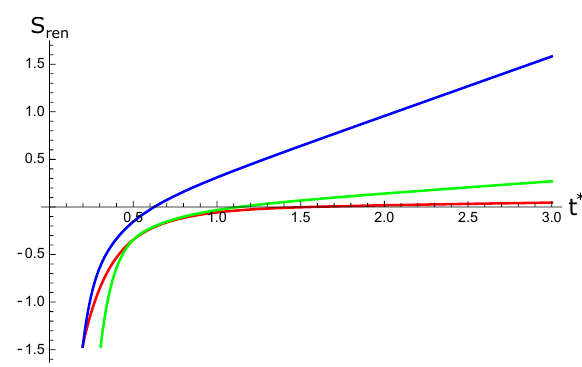
Figure 14 . The renormalised action S d (cid:0) ren as a function of t (cid:3) . The plots are for B = 0 : 6 ; 1 ; 3 from red to blue. For large loop, the angle t (cid:3) approaches (cid:25) and the action is found to scale approximately linearly with t (cid:3) , while for smaller t (cid:3) it grows slower (logarithmically). The approximately linear behaviour is reached faster for large values of B and the slope scales as